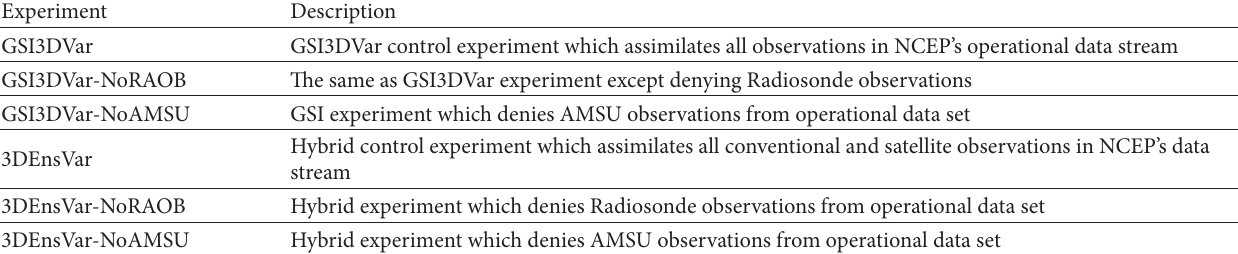
Table 1: List of